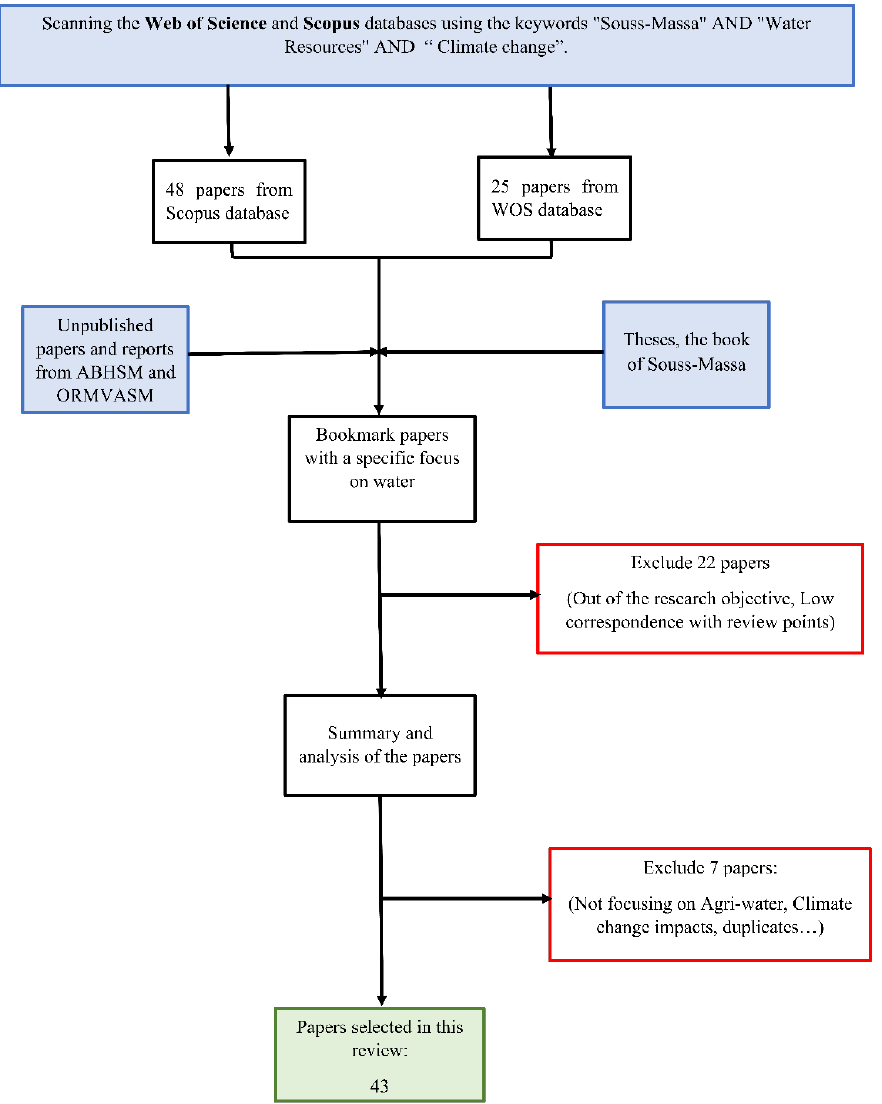
Figure 3. Flowchart for the selection of literature.